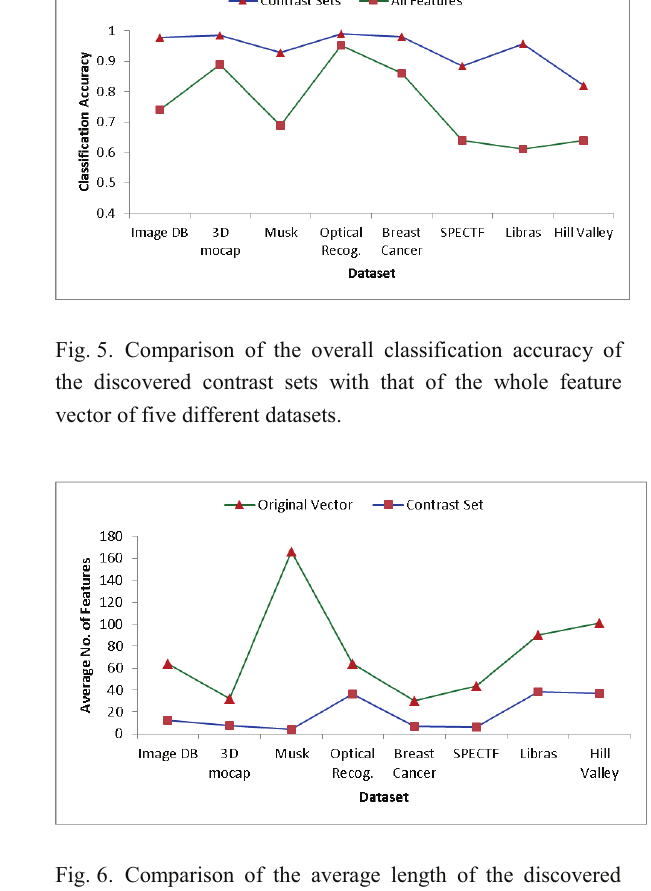
Table 1) versus using the discovered contrast